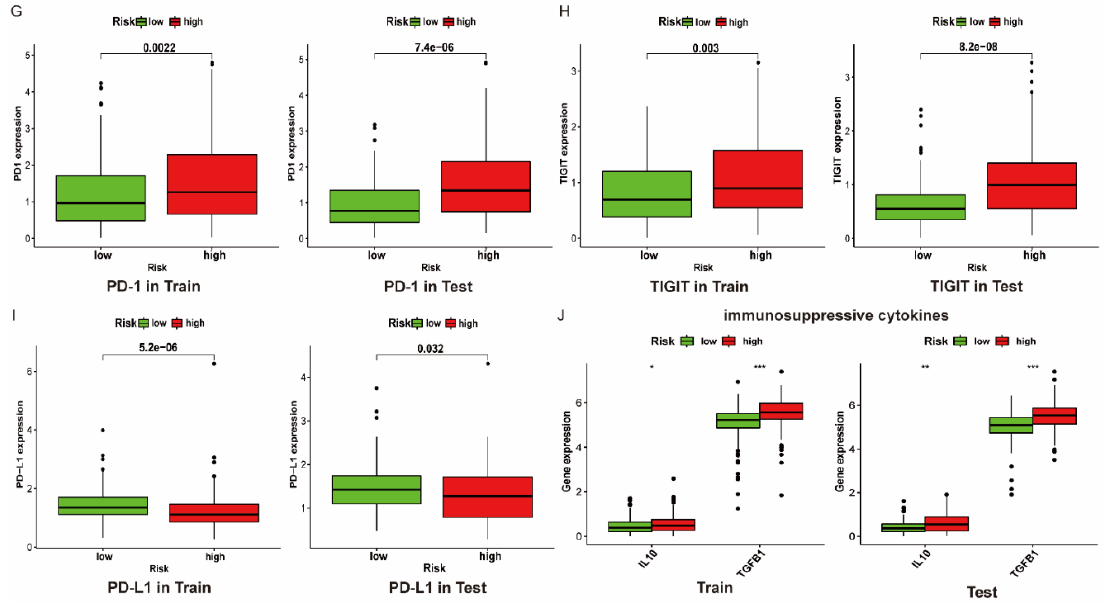
Figure 8. High collagen-related risk score indicates an immunosuppressive microenvironment. ( A , B ) Heatmap of gene profiles involved in the negative regulation of the cancer immunity cycle in high and low risk groups in train and test cohorts; ( C ) Correlation between LAG3 expression and risk score; ( D ) LAG3 expression in high and low risk groups; ( E ) Correlation between CTLA-4 expression and risk score; ( F ) CTLA-4 expression in high and low risk groups; ( G – I ) PD1,TIGIT, and PD-L1 expression in high and low risk groups; ( J ) Tumor immunosuppressive cytokines expression in high and low risk groups; * p < 0.05,** p < 0.01 and *** p < 0.001.